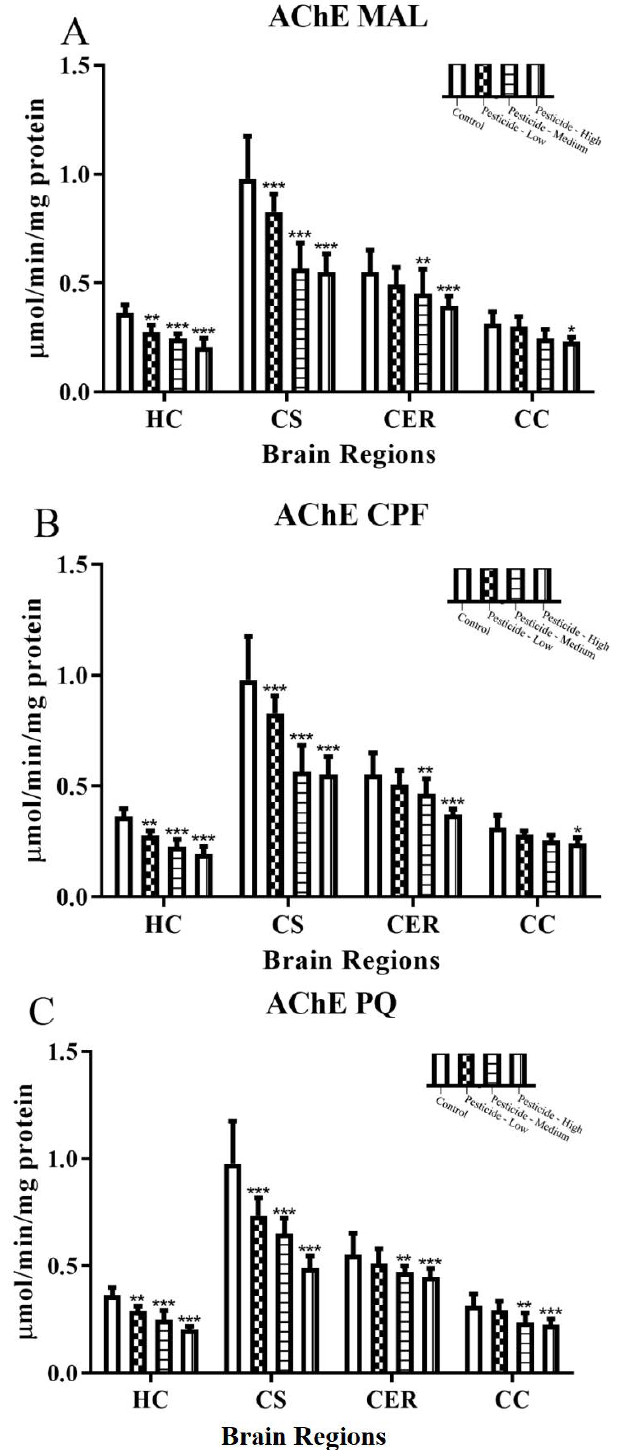
Figure 1. Pesticide-induced inhibition of brain AChE activity. Rats were dosed with malathion (MAL) ( A ); chlorpyrifos (CPF) ( B ); or paraquat (PQ) ( C ); at low, medium, or high dosages and the level of acetylcholinesterase (AChE) activity quantified within the hippocampus (HC), corpus stri- atum (CS), cerebellum (CER), and cerebral cortex (CC). Histograms are representative of mean val- ues with SDs, with significant changes marked with asterisks, according to * p < 0.05, ** p < 0.01, and *** p < 0.001. Endogenous NTE activity was relatively uniform across the brain regions, but the vulnerability of the HC and CS brain regions to the effects of pesticides was evidenced by the significant inhibition of NTE by all three pesticides and at all of the pesticide doses (Figure 2A–C). By comparison, low pesticide dosing for either MAL, CPF, or PQ was in- effectual for inhibition of NTE within either the CER or CC brain regions (Figure 2A–C). Furthermore, the levels of inhibition of NTE at high pesticide dosing were 28–52% for the HC, 49–58% for the CS, but only 25–32% for the CER, and 20–25% for the CC. A two-way ANOVA confirmed that the pesticide inhibition of AChE or NTE reflected pesticide dose and brain region (Supplementary Table S1).